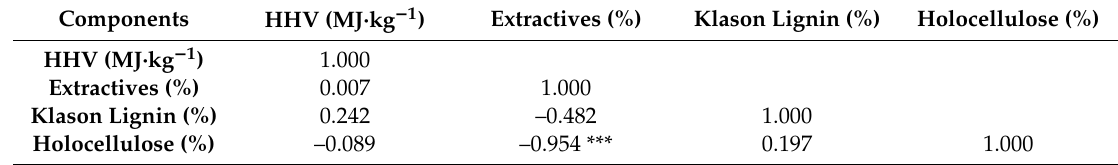
Table 3. Correlation coe ffi cient matrix of HHV (MJ · kg − 1 ), and chemical composition analysis (%). Components HHV (MJ · kg − 1 ) Extractives (%) Klason Lignin (%) Holocellulose (%) HHV (MJ · kg − 1 ) 1.000 Extractives (%) 0.007 1.000 Klason Lignin (%) 0.242 –0.482 1.000 Holocellulose (%) –0.089 –0.954 ***